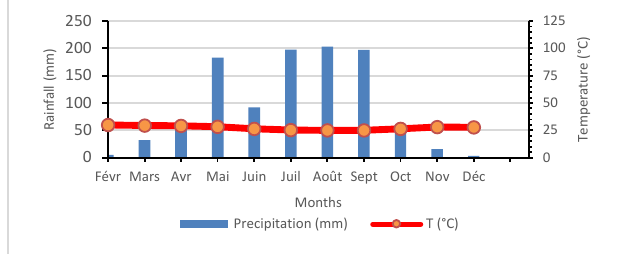
Figure 5: Ombrothermal diagram of stations in the region